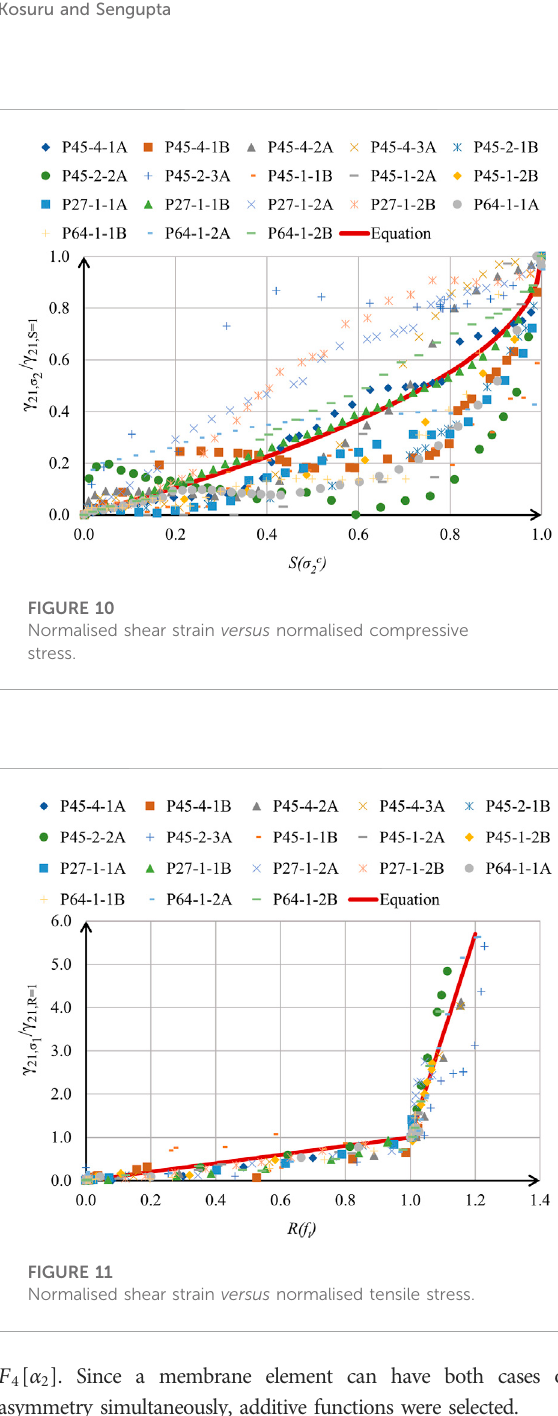
FIGURE 11 Normalised shear strain versus normalised tensile stress.